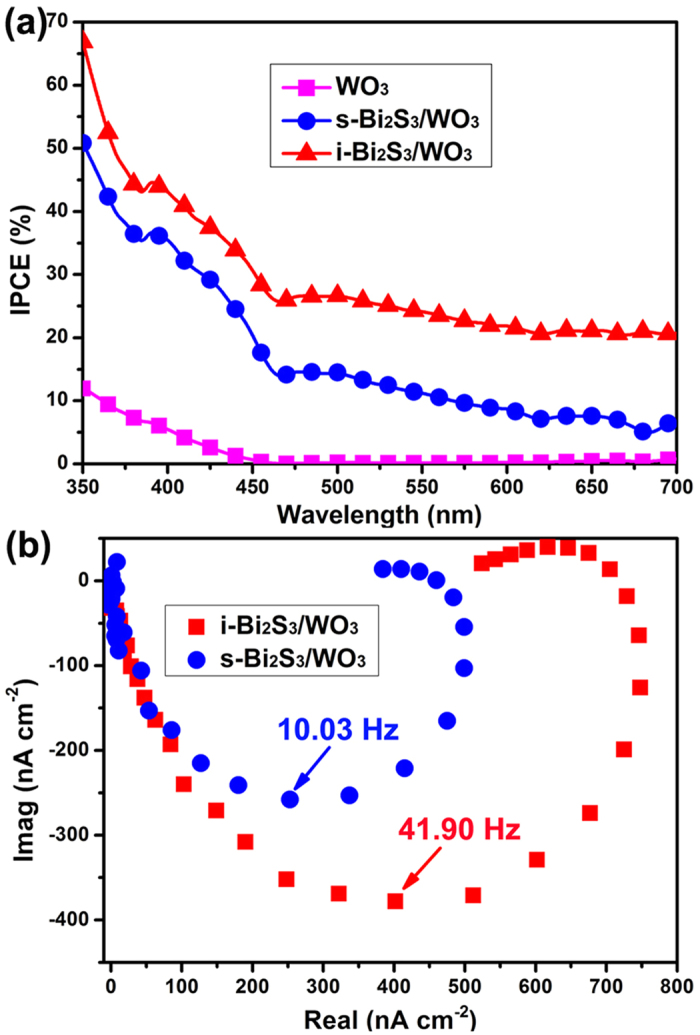
(a) IPCE spectra and (b) complex plane plot of the IMPS response for s-Bi2S3/WO3 and i-Bi2S3/WO3 photoelectrodes.